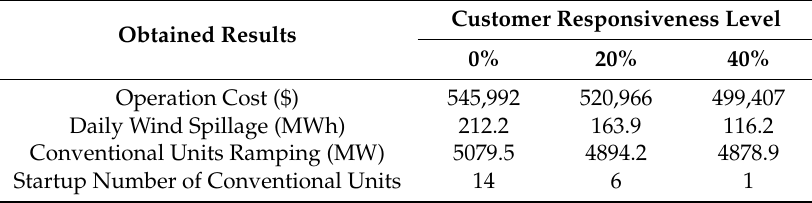
Table 2. A summary of techno-economic results of different customer responsiveness